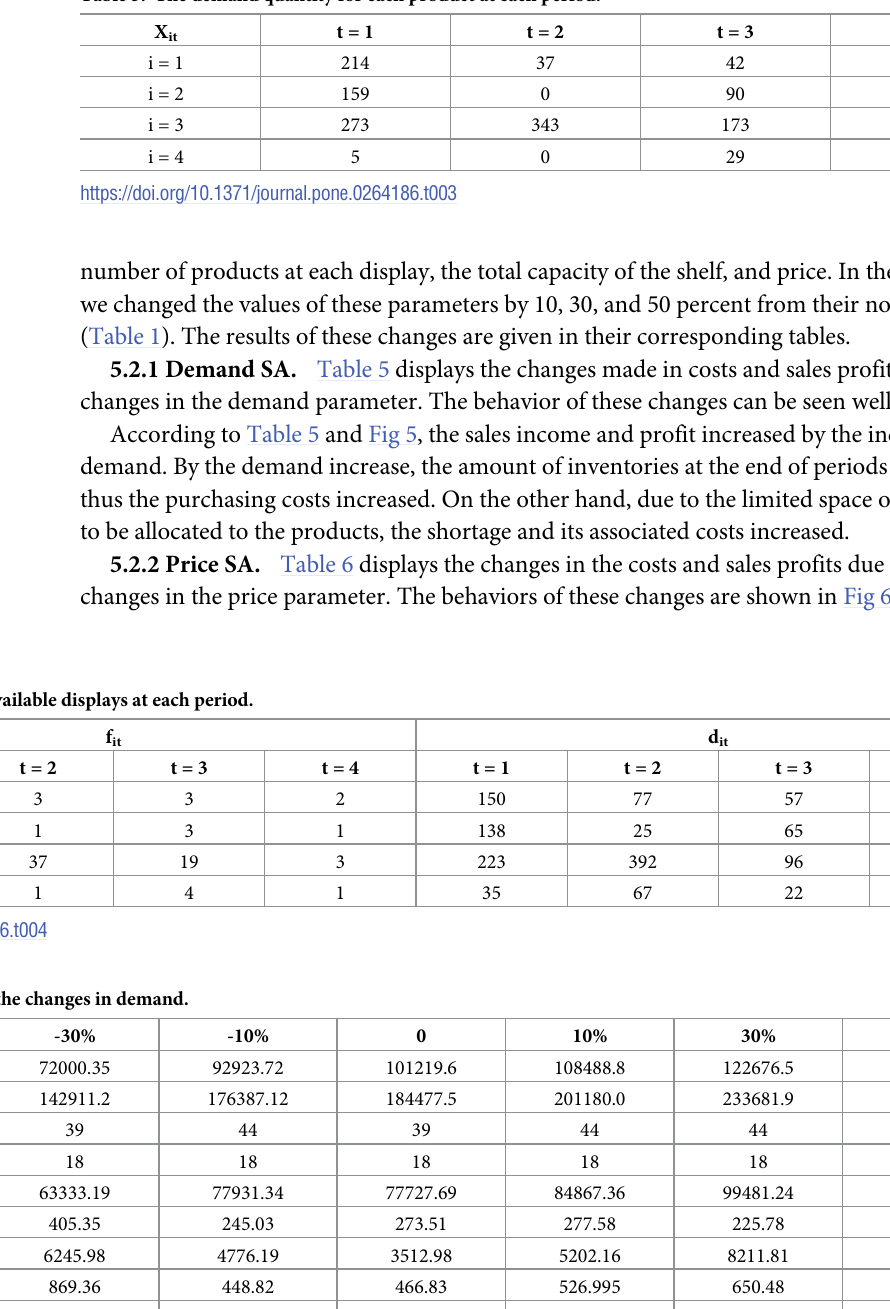
Table 3. The demand quantity for each product at each